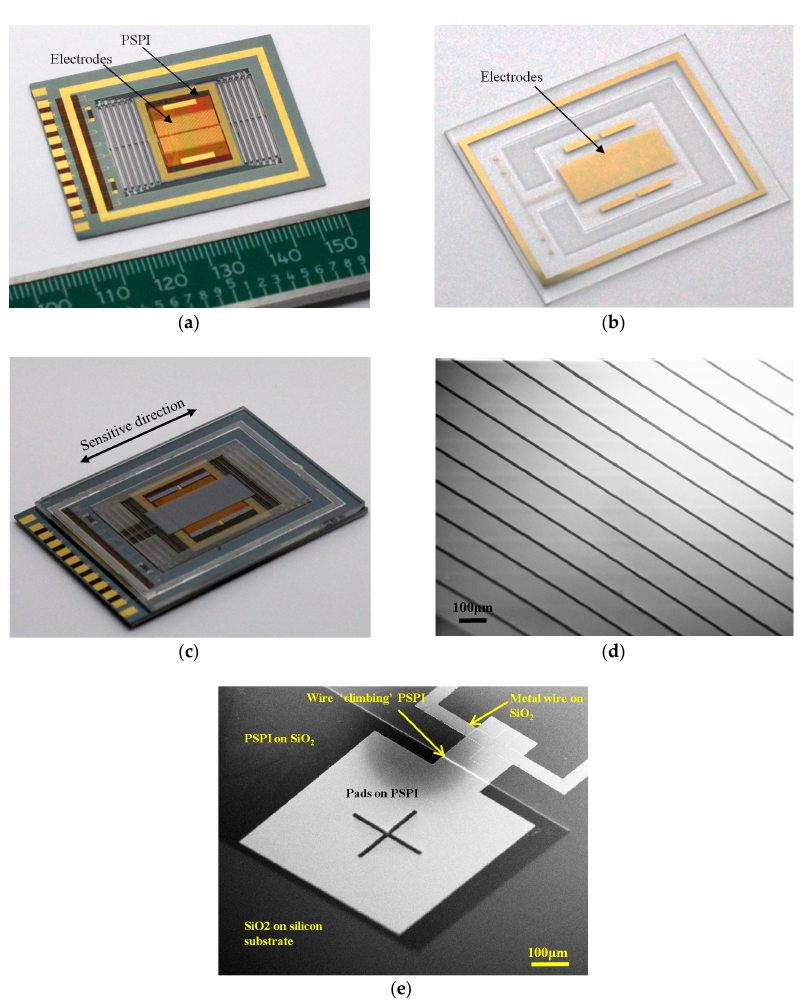
Figure 5. Fabricated micro accelerometer. ( a ) Electrodes on the spring-mass structure; ( b ) Electrodes on the top die; ( c ) Packaged micro accelerometer in which the electrodes on the top die and spring-mass structure form the area-changed capacitive transducer; ( d ) SEM photograph of the electrodes; ( e ) Additional PSPI between the metal layer and silicon substrate, the wire climbs the edge of the PSPI for transferring the signal from the electrodes and pads on PSPI. Table 2. Summary of the key parameters of the